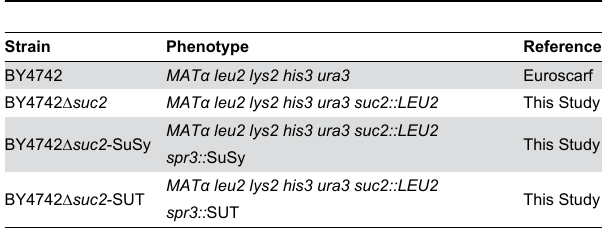
Table 1. Yeast strains used in this study.